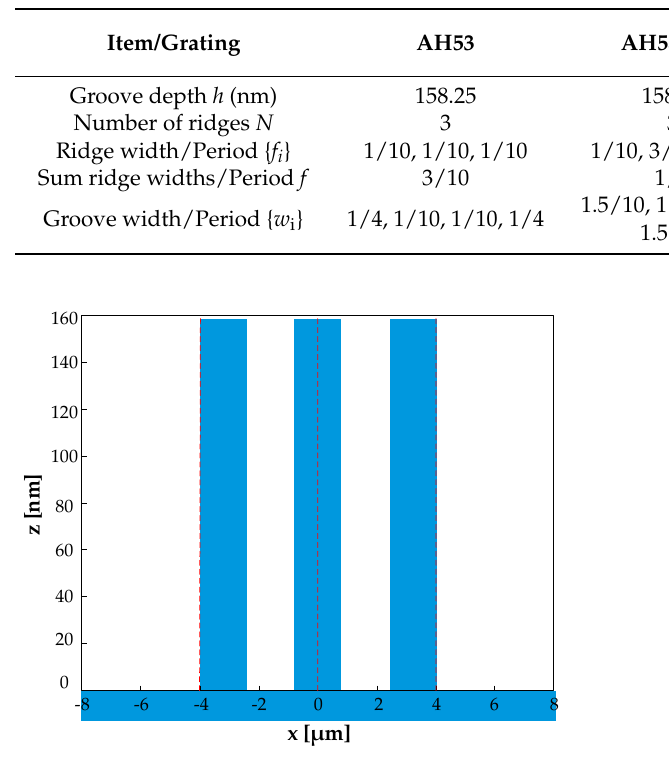
Figure 16. The structure of AH53 in one period. Table 3. Comparison the efficiency of each order for AH53 and AH53_opt.